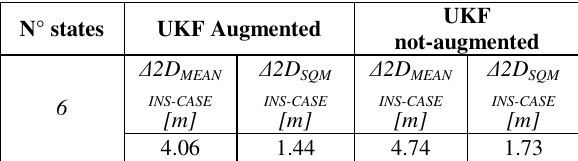
Table 4. Delta mean and delta standard deviation between INS and UKF augmented or not-augmented applied to the motion model with 6 states